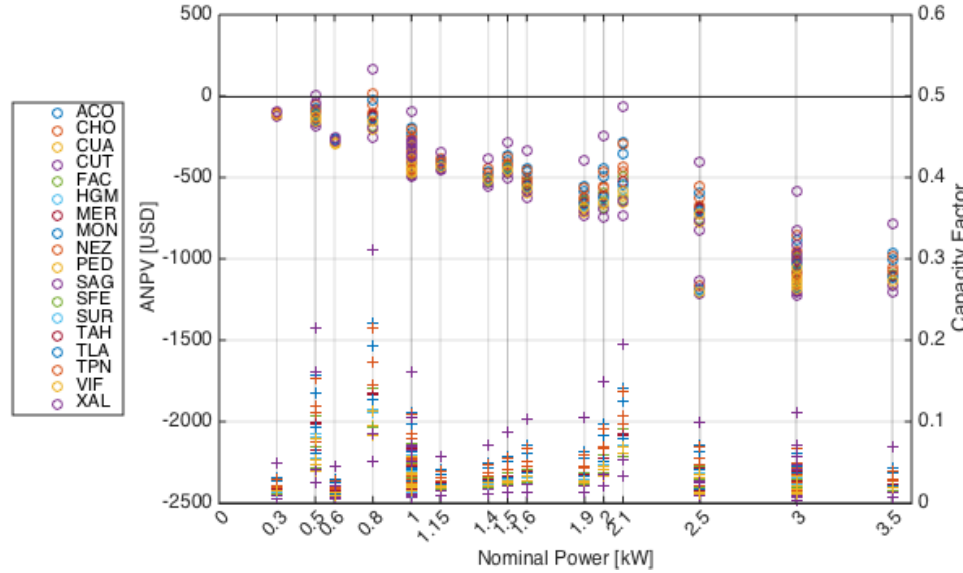
Figure 15. ANPV and CF are represented by the symbols ◦ and + , respectively. Similar wind conditions are present within the